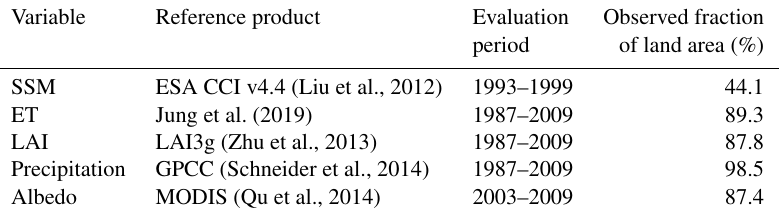
Table 1. Overview of the selected reference data sets and period of analysis. The last column gives the percent of land pixels, in the maps of Figs. 2 and 3, with observed values. A smaller amount of SSM data is available compared to the others as a result of relatively strict quality control. For ET and LAI, no data were available in extremely arid